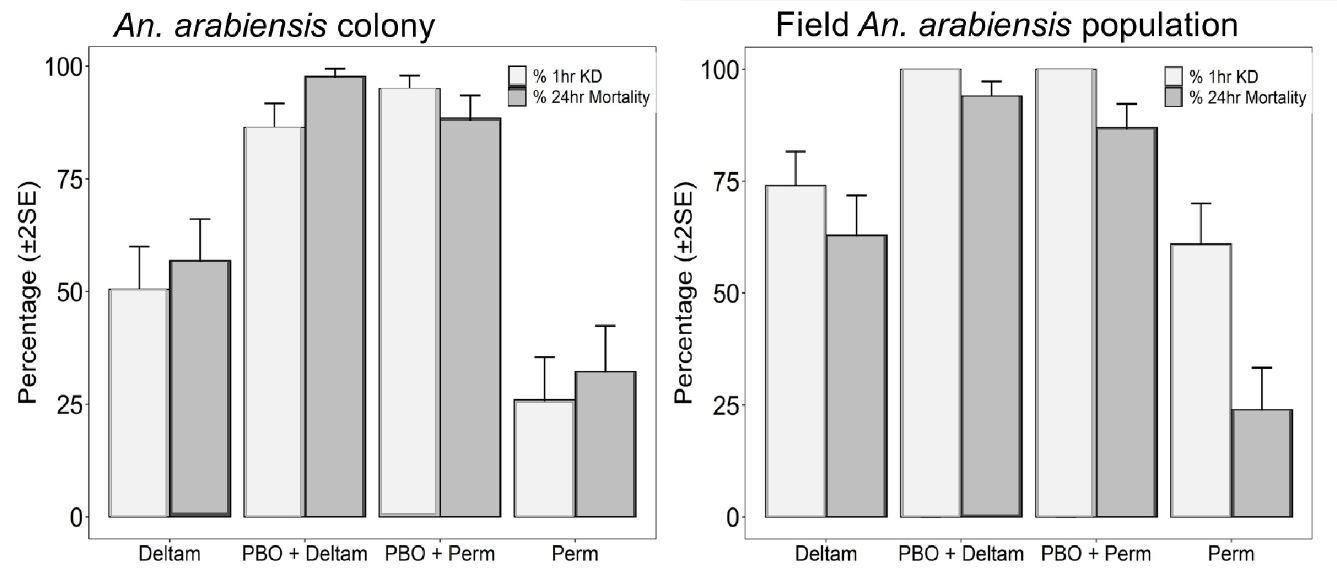
Fig 6. Knockdown time and mortality rates of resistant: An . arabiensis colony population and An . arabiensis wild population. Increase in mortality and knockdown rate (KD) to 0.05% Deltamethrin and 0.75% Permethrin was observed following 1-hour pre-exposure to synergist; PBO = P450 inhibitor.